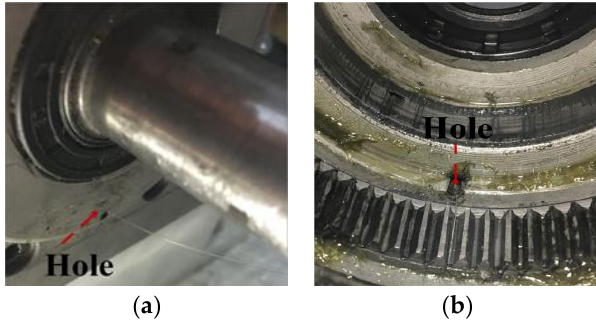
Figure 17. Installation of ( a ) FBG1 and ( b ) FBG2 in the experiment.